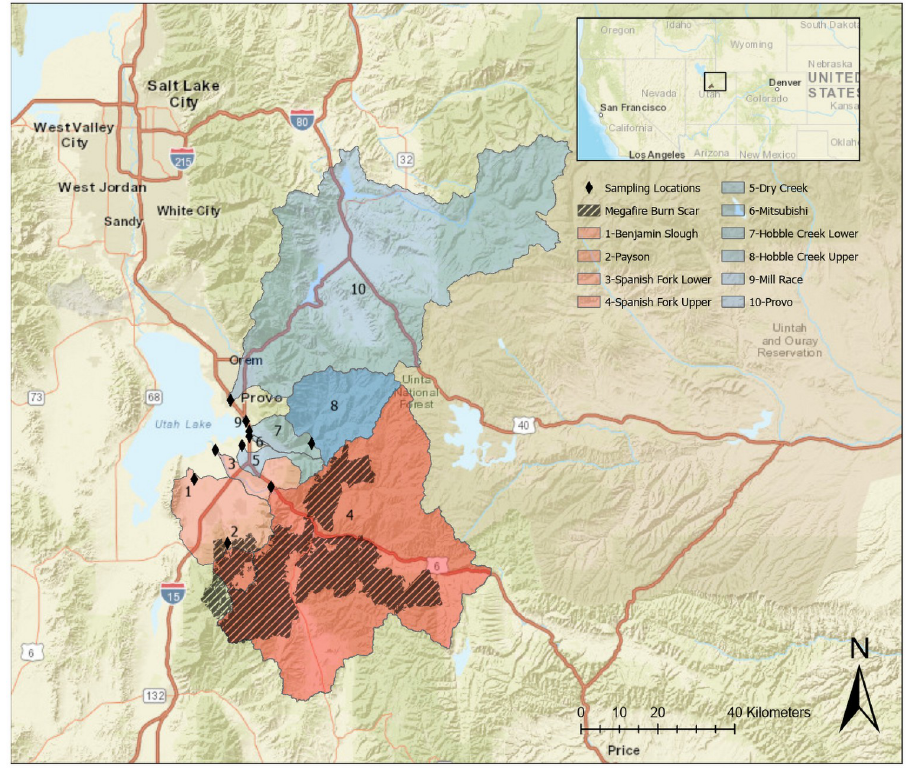
Fig 1. Map showing the megafire burn scar, sampling locations, and contributing watersheds. Watersheds are displayed as either red (burned) or blue (unburned) with numbers indicating the river or stream name in the legend. The map was created using opensource data from the USGS National Map and the Earth Resources Observation and Science